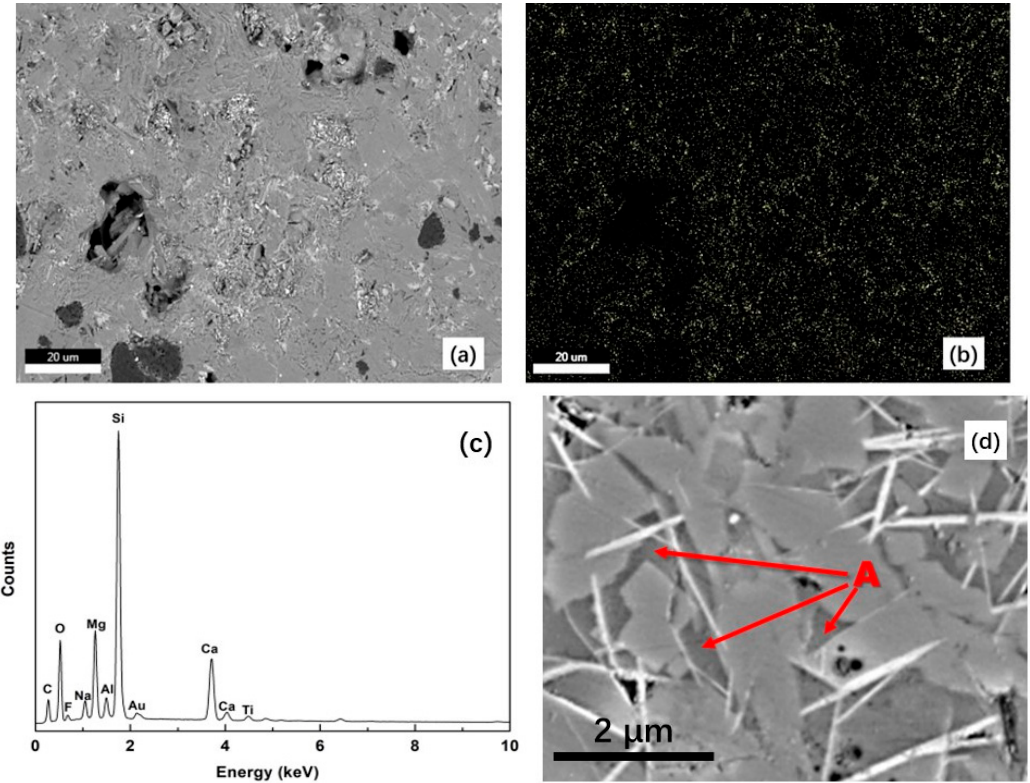
Figure 5. Typical backscattered electron image of final slag ( a ), distribution of Ti-bearing phase ( b ), and EDS analyses of the Ti-bearing phase ( c ). Ti-bearing phase (A) is in an amorphous state that is dispersed in solidified slags ( d ). Sample obtained in slag with basicity index of 1.4. Table 4. Typical composition of Ti-bearing phase in solidified slag, wt%.